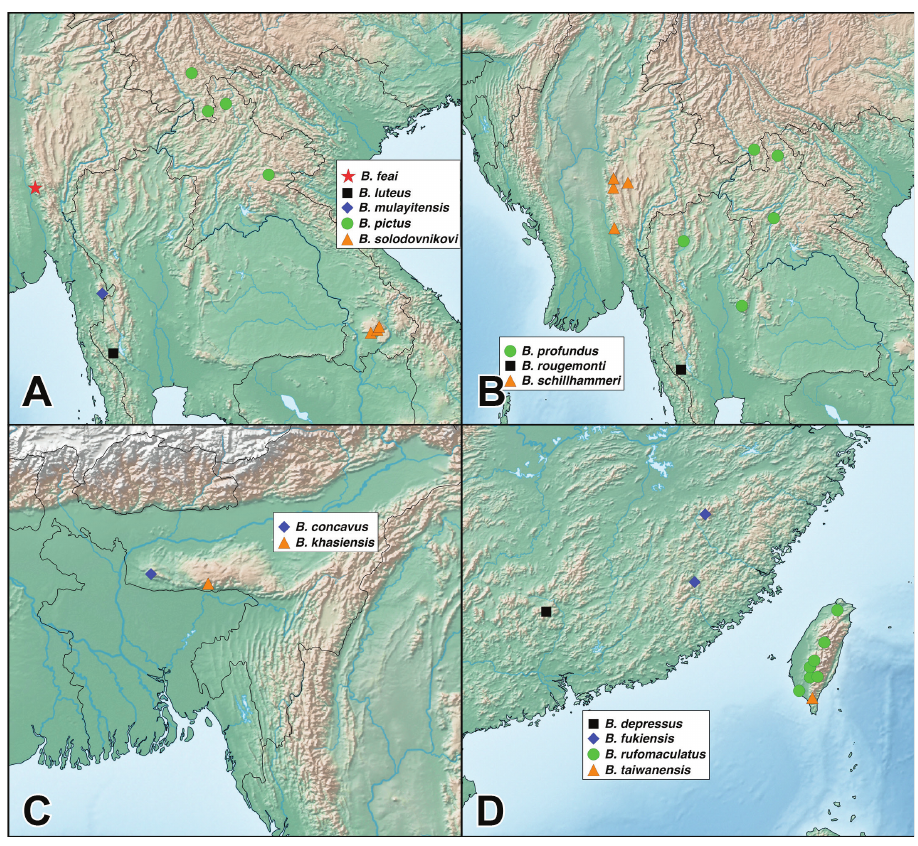
Figure 21. Distribution of: Bolitogyrus feai Brunke, B. luteus Brunke, B. mulayitensis Brunke, B. pictus Smetana & Zheng, and B. solodovnikovi Brunke ( A ); B. profundus Cai et al., B. rougemonti Brunke, and B. schillhammeri Brunke ( B ); B. concavus Brunke and B. khasiensis Brunke ( C ); B. depressus Cai et al., B. fukiensis (Scheerpeltz), B. rufomaculatus (Shibata) and B. taiwanensis (Hayashi) ( D